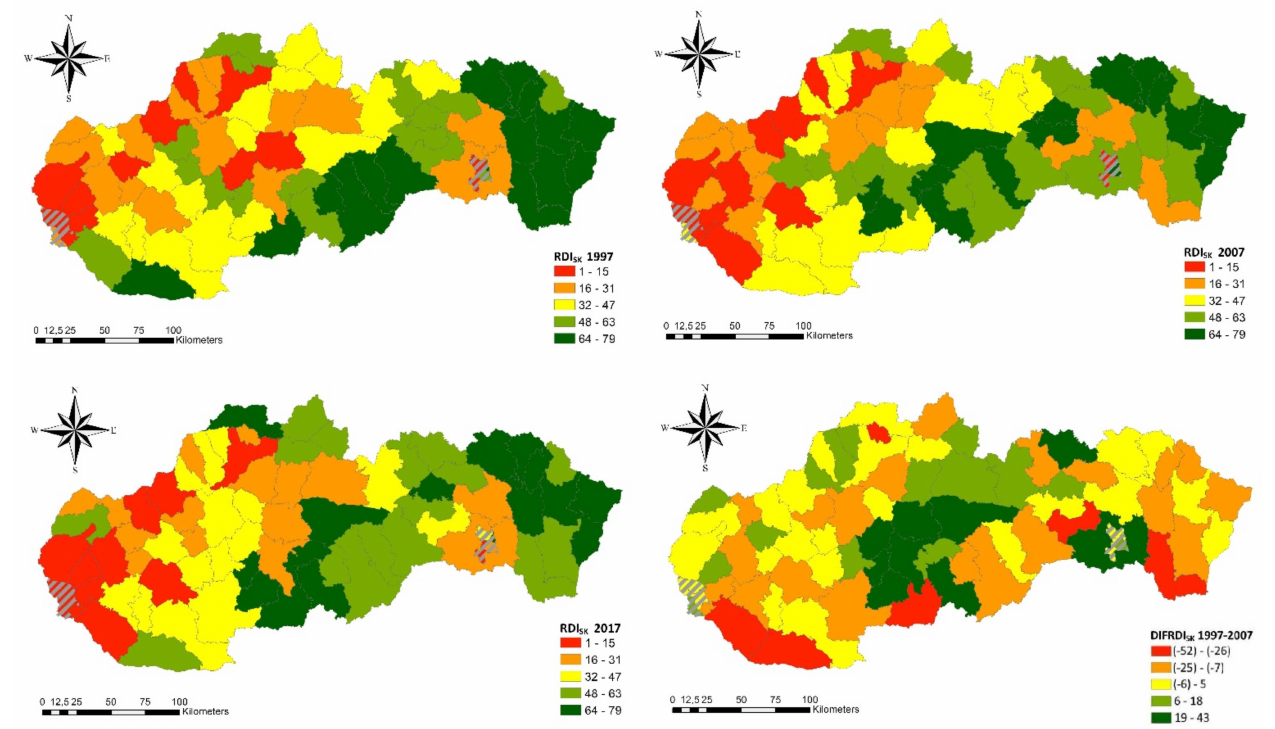
Figure 5. RDI SK for Slovak districts in 1997, 2007 and 2017. Source: the